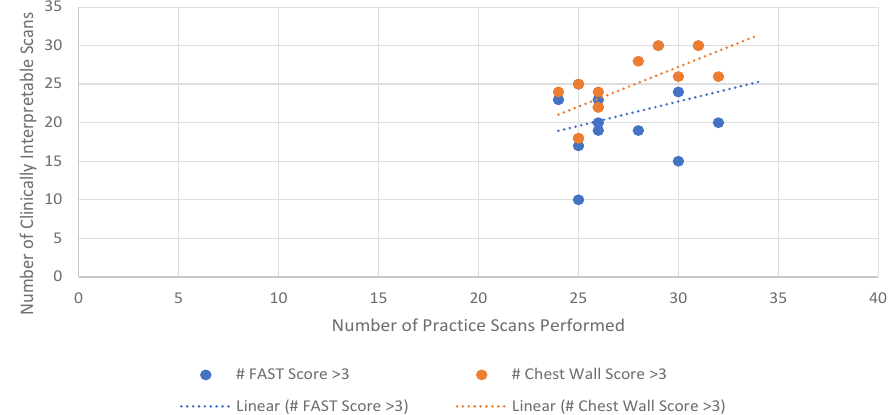
Figure 1: Number of Clinically Interpretable Scans by Number of Scans Performed